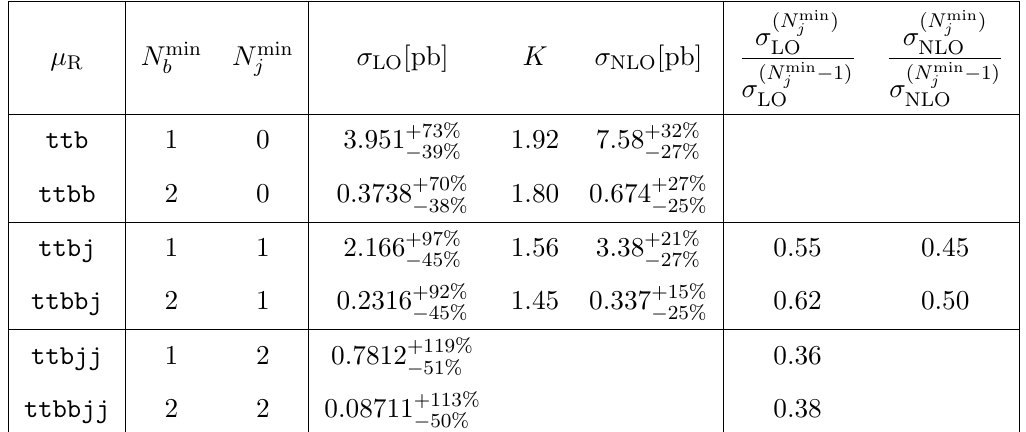
t (cid:22) tb (cid:22) b +jets at p s = 13 TeV. Results are shown for ! = 1 ; 2, and extra light jets, N min = 0 ; 1 ; 2. j b = 0 are based on a t (cid:22) tb (cid:22) b calculation j